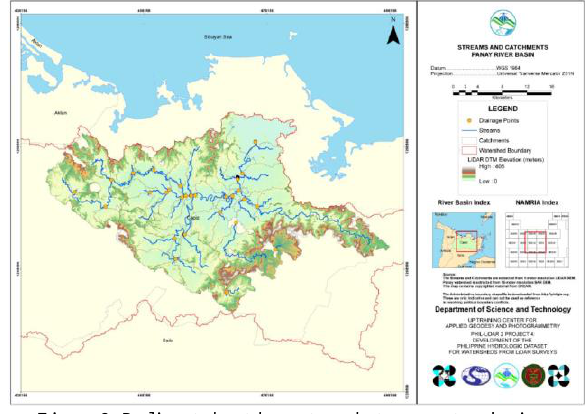
Figure 3. Delineated catchments and stream networks in a